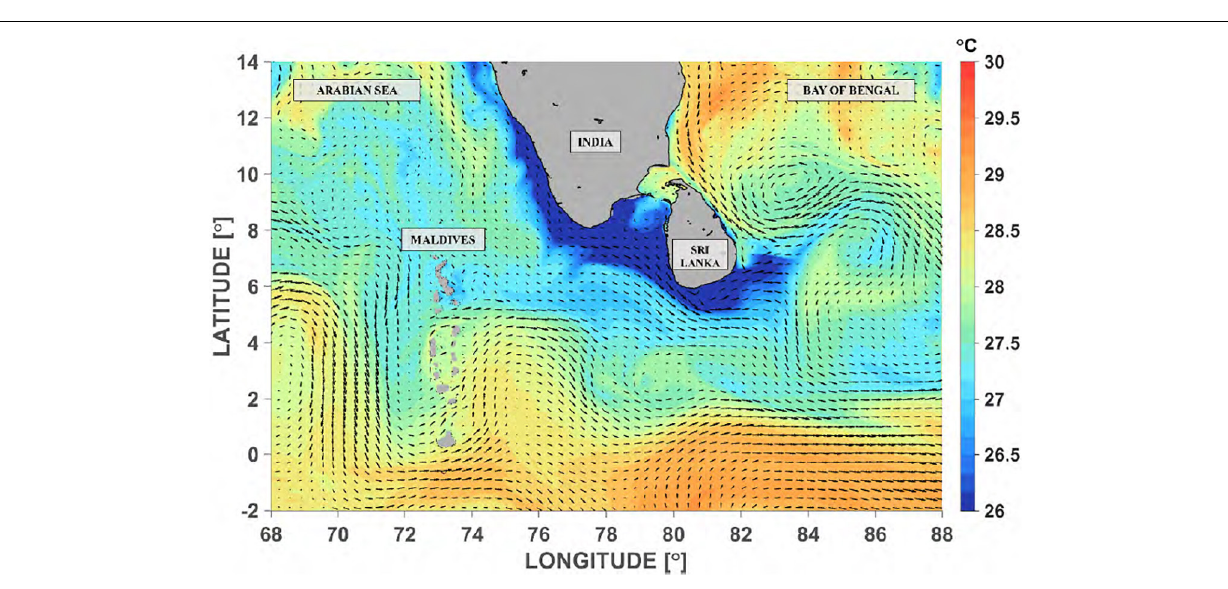
FIGURE 8 | Surface flow patterns (arrows) and sea surface temperature (color) in July, during the SWM showing the circulation around the Maldives and flow separation and the formation of the Sri Lanka Dome to the east of Sri